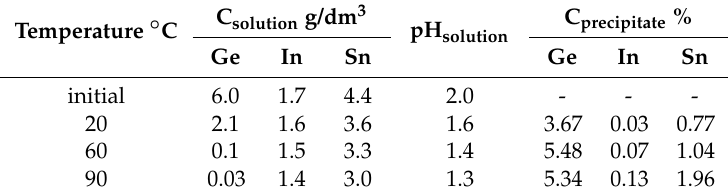
Table 1. Composition of the solution and precipitate after precipitation with tannic acid (2 h, 100 g/dm 3 pure tannic acid, 1 portion).